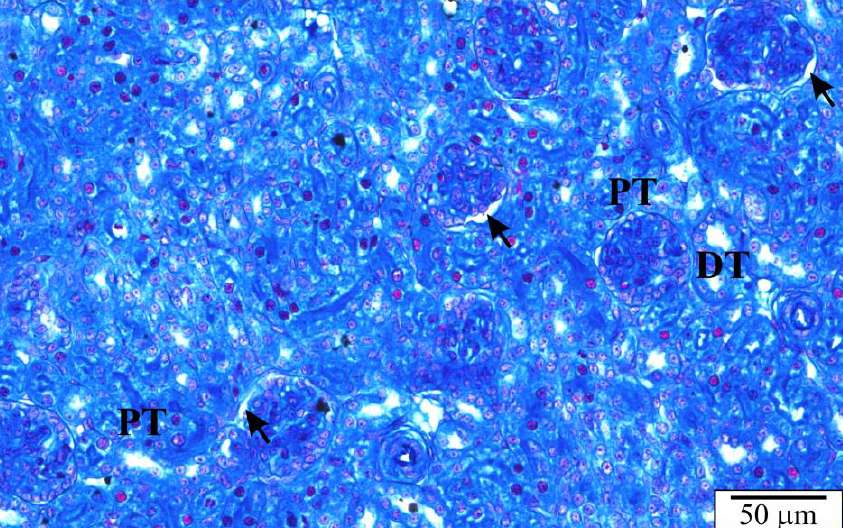
Figure 4. The renal cortex of a rat with congenital babesiosis. DT—distal tubules, PT—proximal tubules, arrows—dilated places of the urinary space of the renal corpuscles.